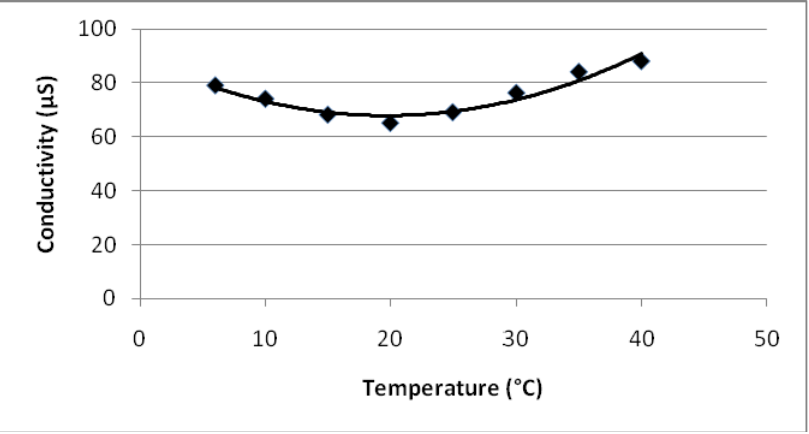
Figure 18. Conductivity vs. temperature change of copolymer (II) with dopant (LiClO Copolymer (II): (20% MMA, 80% EGDMA in monomer feed).